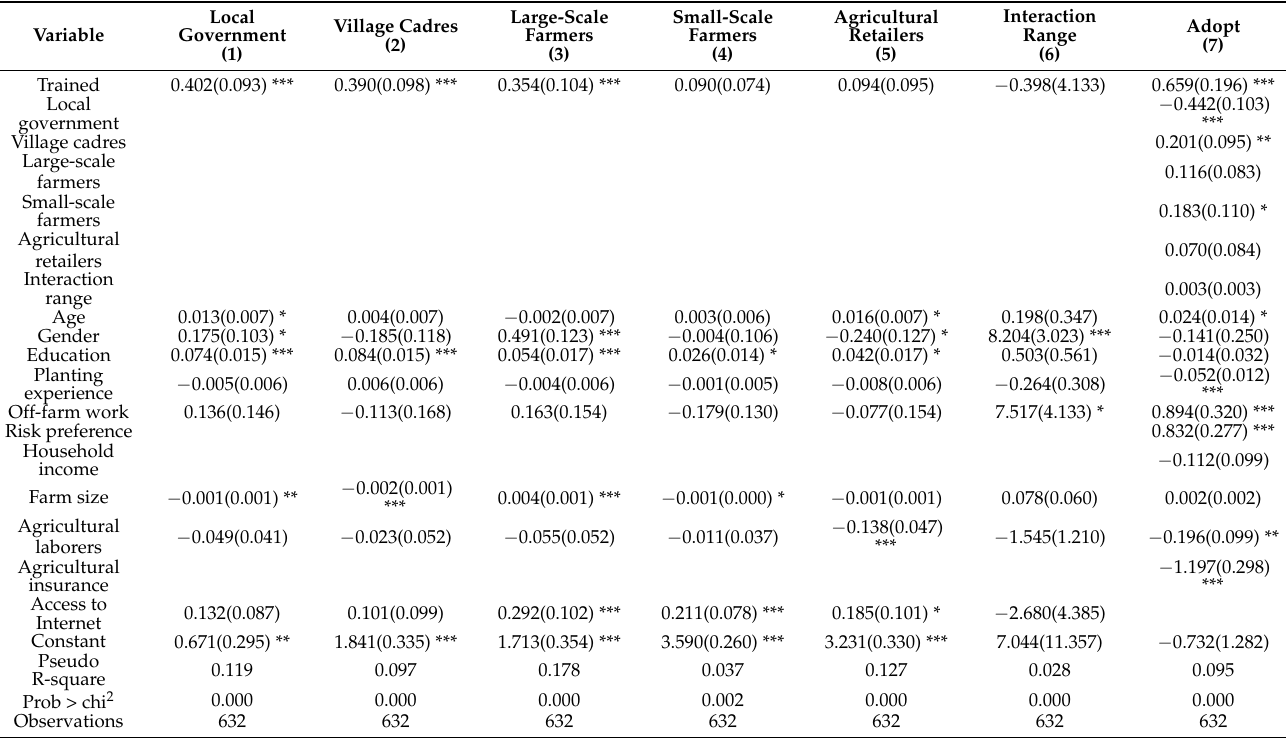
Table 7. The mediating effect of farmers’ social